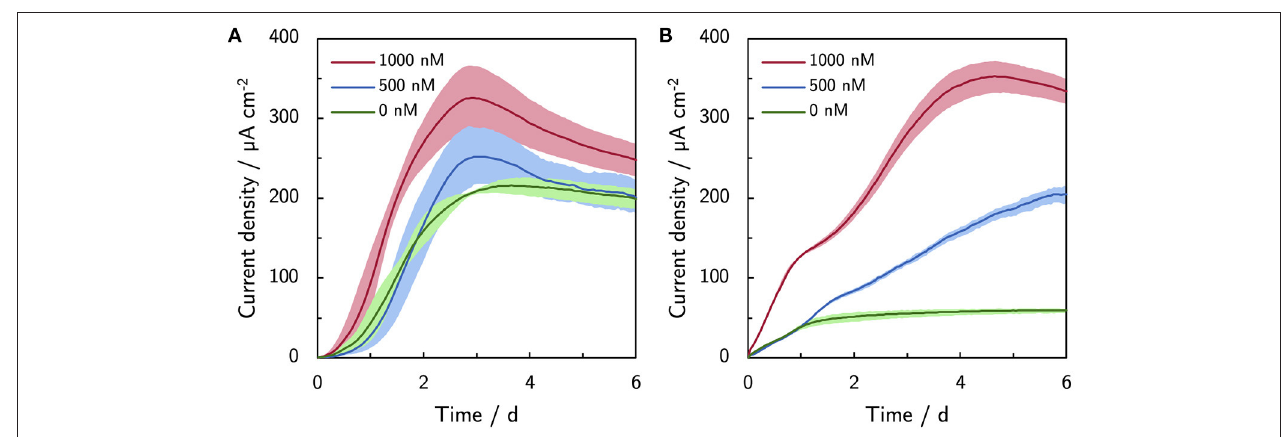
Frontiers in Microbiology |